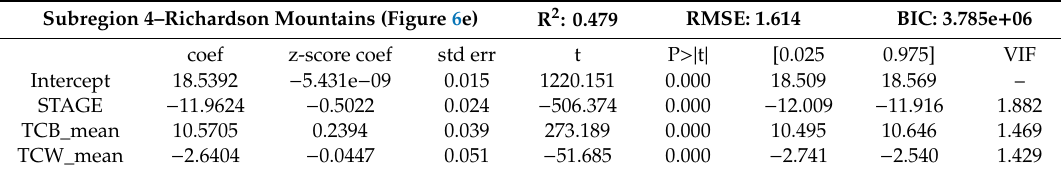
Table A7. Multiple linear regression output as obtained for the subregion “Richardson